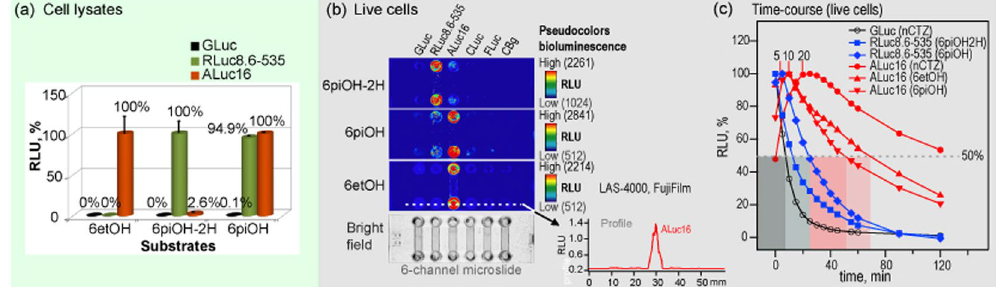
Figure 2. Biased selectivity of the synthetic luciferins to marine luciferases. ( a ) The relative selectivity of representative synthetic luciferins according to luciferases in cell lysates. ( b ) The corresponding live-cell images on a 6-channel microslide, demonstrating the relative luciferase-selectivity of the selected coelenterazine (CTZ) analogues in living mammalian cells. The optical intensity ranges of 6piOH-2H-CTZ, 6etOH-CTZ, and 6piOH-CTZ were 1024–2261, 512–2214, 512–2841 RLU, respectively. ( c ) The time course of the optical intensities after substrate injection to the microslide channels growing live cells. The bioluminescence exhibited clearly distinctive time courses according to the chemical structures of the synthetic luciferins and the kinds of marine luciferases. The blue- and red-marked lines indicate the intensity profiles of RLuc8.6-535 and ALuc16 by time, respectively. Greatly enhancing features in the optical intensity by time were observed with ALuc16. Abbreviations: GLuc, Gaussia princeps luciferase; RLuc8.6-535, Renilla reniformis luciferase 8.6-535; ALuc16, artificial luciferase 16; CLuc, Cypridina luciferase; FLuc, firefly luciferase; CBgreen, click beetle luciferase